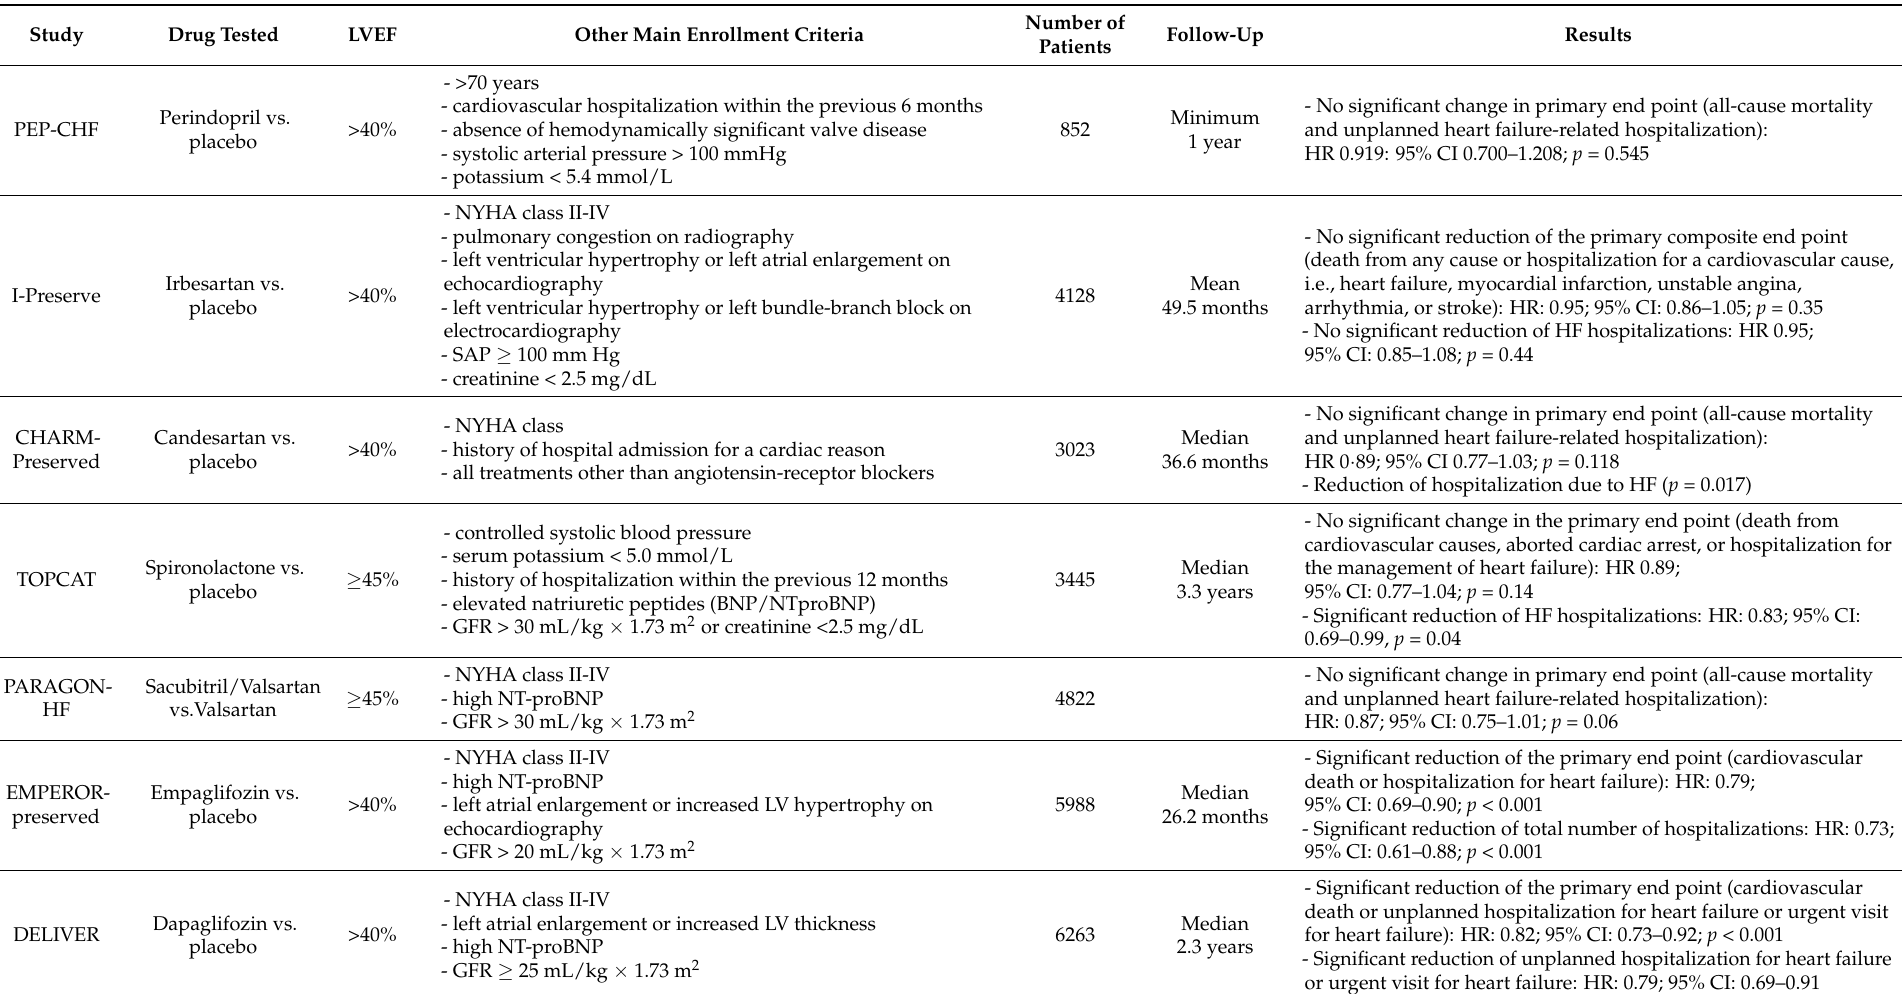
Table 1. The main studies evaluating the efficacy of pharmacologic approaches in patients with heart failure and mildly reduced or preserved ejection fraction; different inclusion criteria and patient characteristics may affect primary